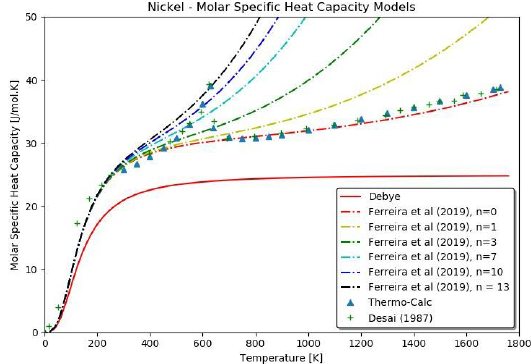
Figure 6. Comparison of the molar heat capacity of pure Ni by applying Debye, Thermo-Calc, Ferreira’s model, and experimental data from Desai 42 .